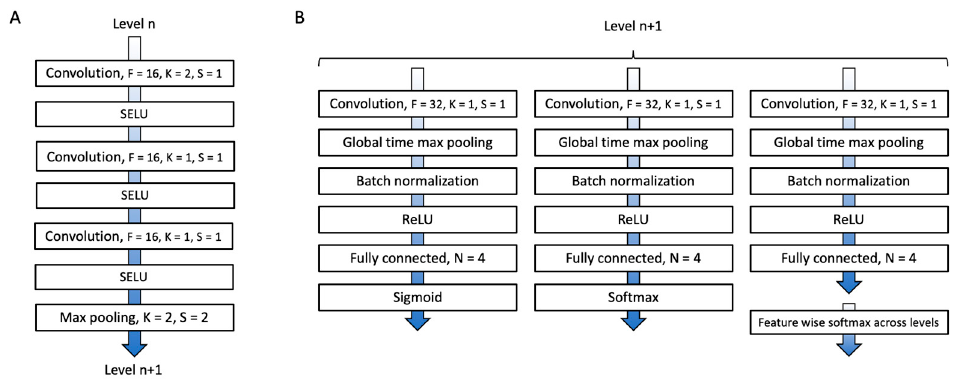
Figure A7. ( A ) Illustration of a convolutional block. ( B ) Illustration of level analysis. F: number of filters; K: kernel size; S: strides; N: number of nodes; ReLU: rectifying linear unit.